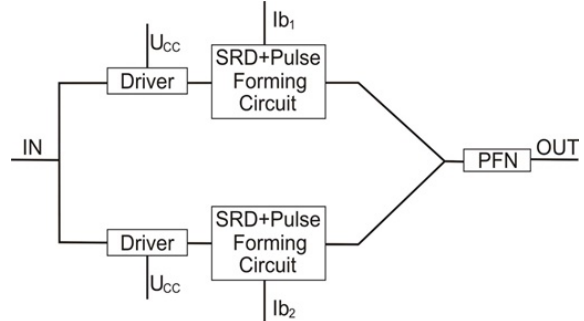
Figure 10: Block diagram of the proposed Radar pulseS transmitter.